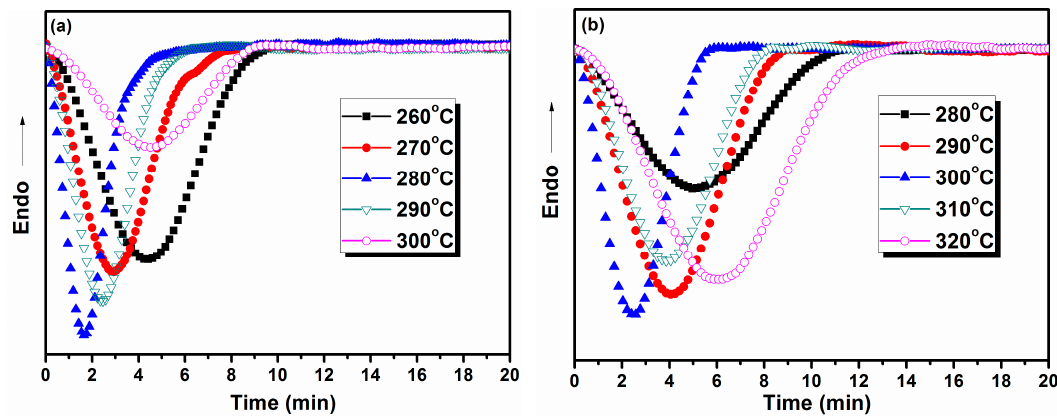
Figure 7. Heat flow versus time for the isothermal crystallization of polyimides at various crystallization temperatures. ( a ) PI-1; ( b ) PI-2. Table 2. Kinetic parameters for PI-1 and PI-2 obtained from isothermal crystallization. Sample